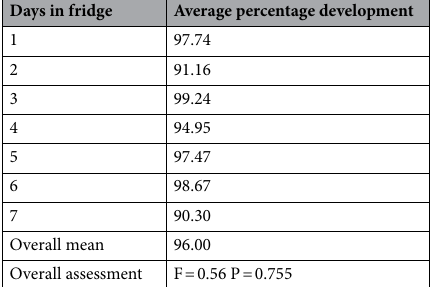
Irradiation dose (Gy)